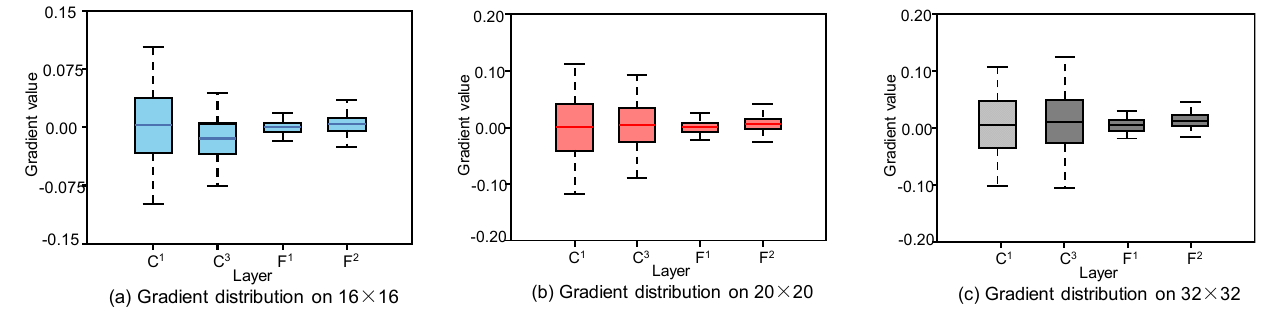
Figure 7. The performance of MoAS-CNN on three-scale datasets. ( a )The losses in training and test- ing process, ( b ) the recognition accuracies in training and testing process. We also record the gradients for all three datasets simultaneously, as shown in Figure 8a–c. The gradient values become larger in the backpropagation, and there is no gradient disappearance. Among them, the gradient value of Conv1 is the largest in the 32 × 32 dataset, making the loss converge quickly. There is no overfitting or underfitting, which indicates that our model and datasets are reasonable.